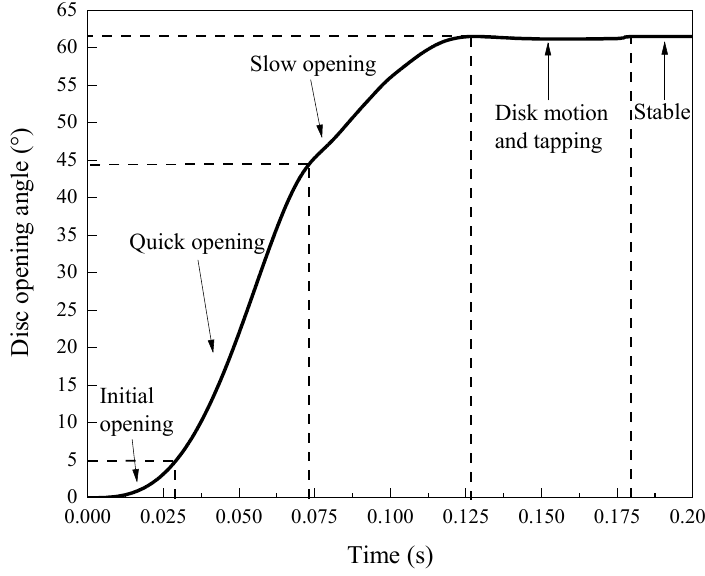
Figure 8. Relation between disc opening angle and time.